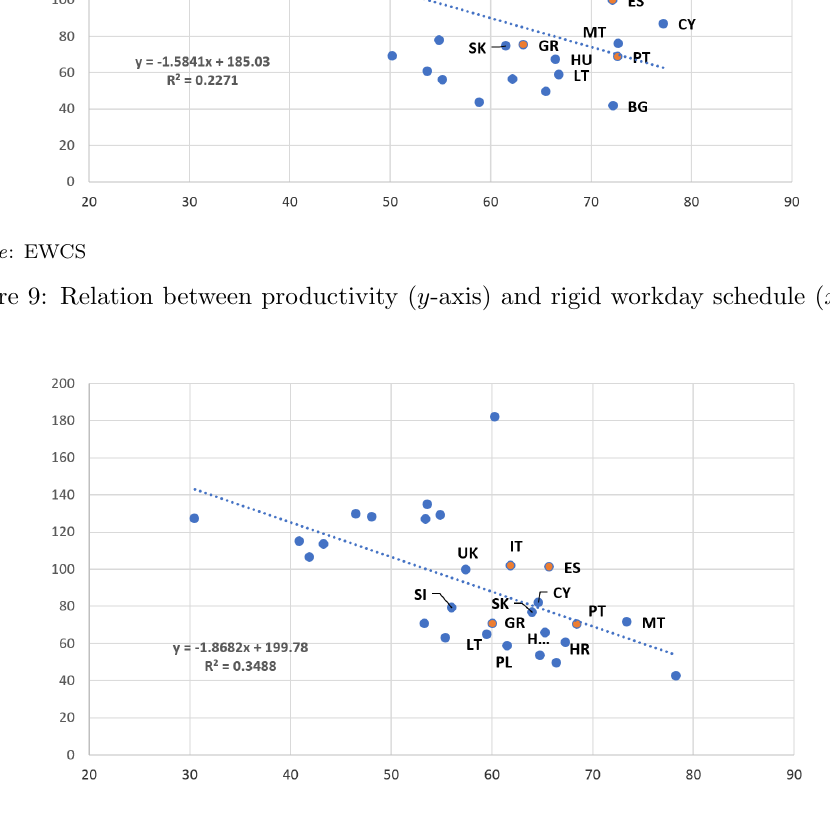
Figure 10: Relation between productivity ( y -axis) and rigid workday schedule ( x -axis),